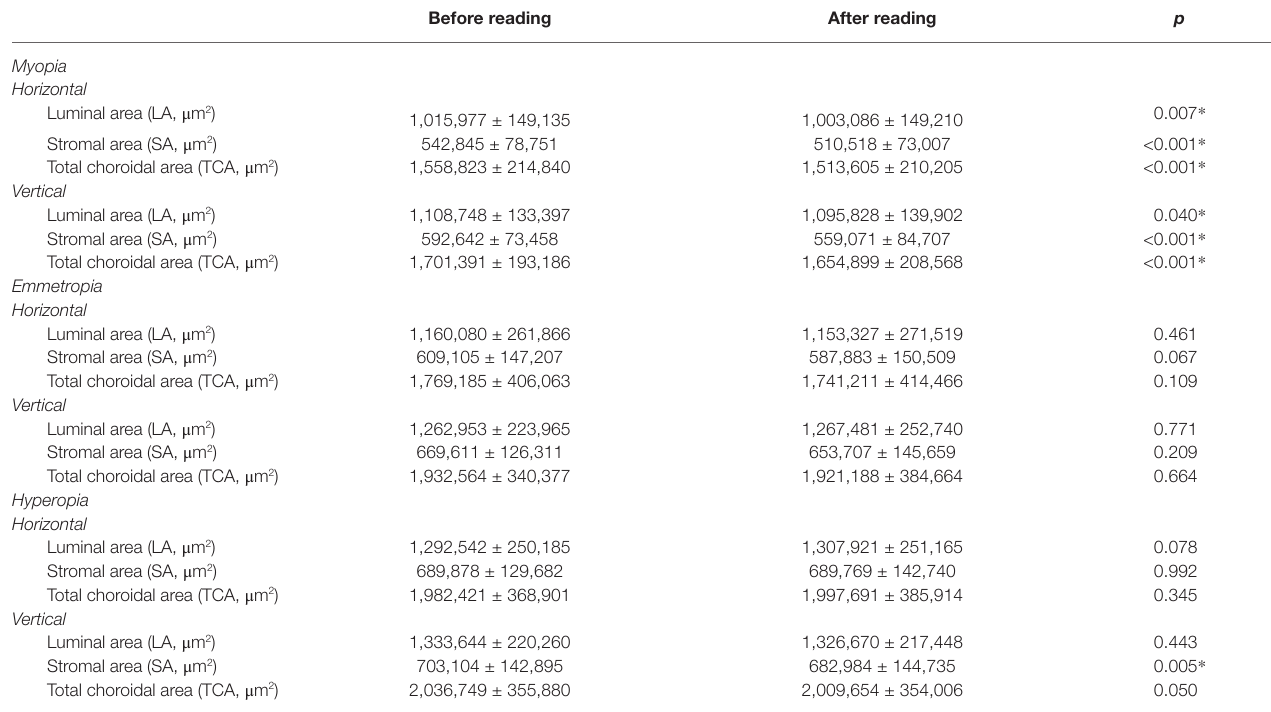
TABLE 6 | Comparisons of CV before and after accommodation in myopia, emmetropia and hyperopia groups. Before reading After reading